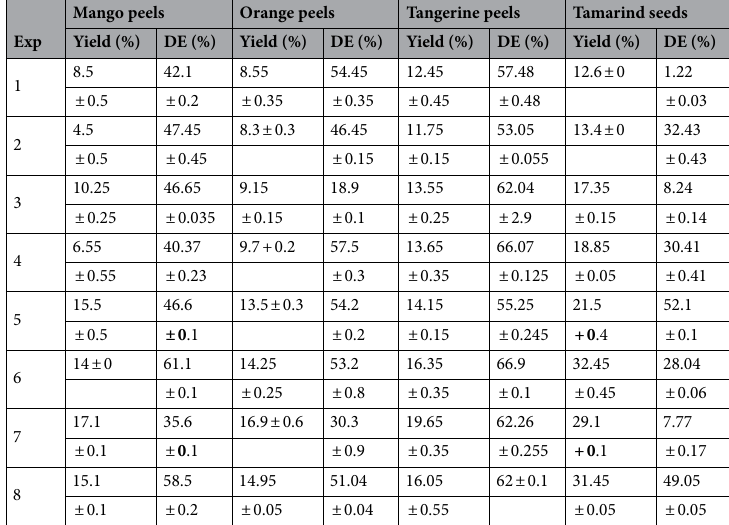
Table 2. % Yield and DE pectin extraction from mango peels, orange peels, tangerine peels and tamarind